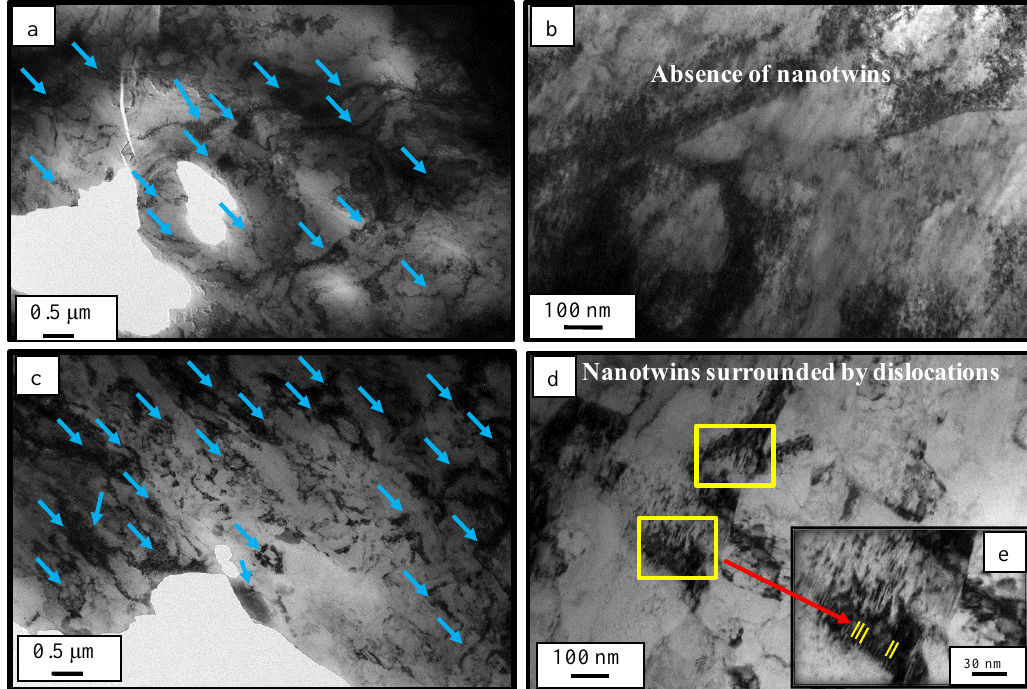
Figure 5. TEM of cold rolled copper ( a , b ) and cryo-rolled copper ( c , d ). ( e ) Magnified view (blue arrow mark represents dislocation tangles/clusters).